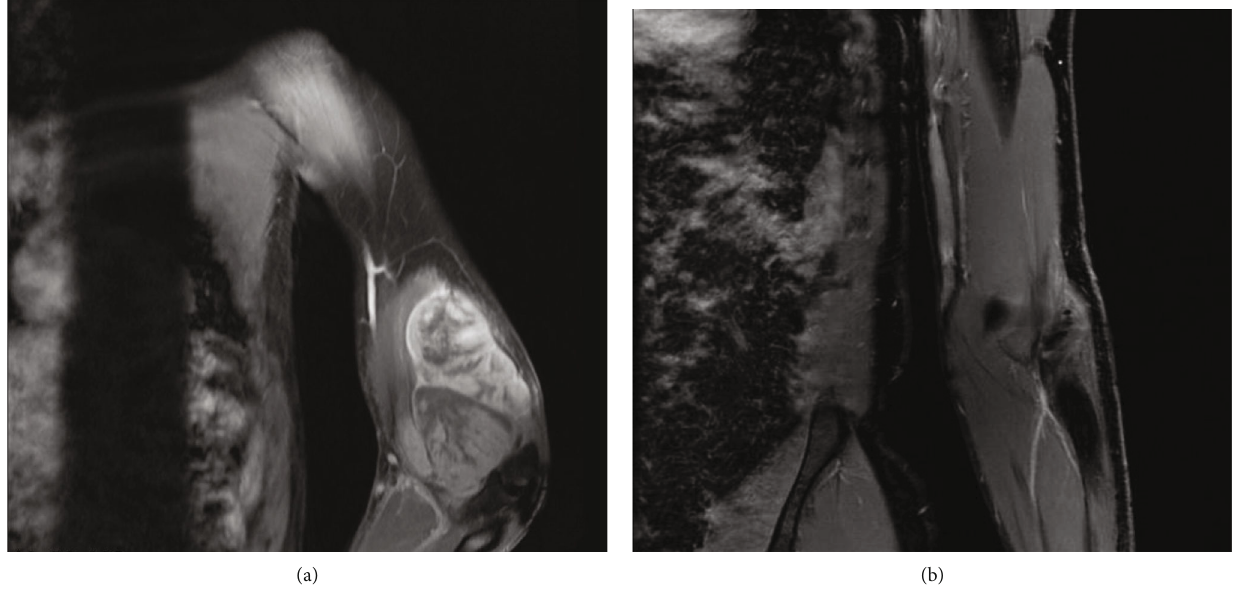
Figure 1: (a) This MRI image was taken at fi rst presentation in 2011. It showed a large lobulated heterogeneous mass extending from the middle of the left arm down to the middle of forearm, measuring 29 × 9 × 9 cm . (b) The last MRI imaging done dated on January 2018. No evidence of circumscribed mass lesion or abnormal enhancement to suggest tumor recurrence. No new lesions identi fi